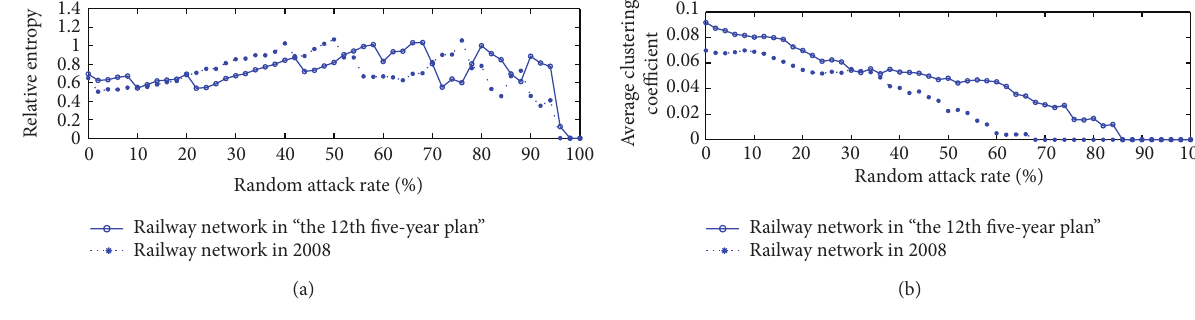
Figure 6: Relative entropy and average clustering coefficient change of railway network under random